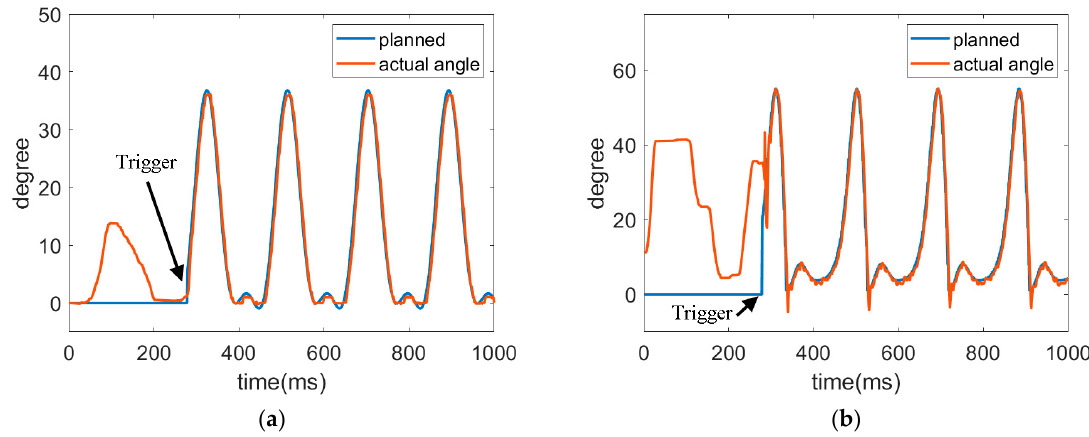
Figure 18. Trajectories of hip joint and knee joint when triggered by a foot leaving the ground. ( a ) Trajectory of hip joint. ( b ) Trajectory of knee joint.